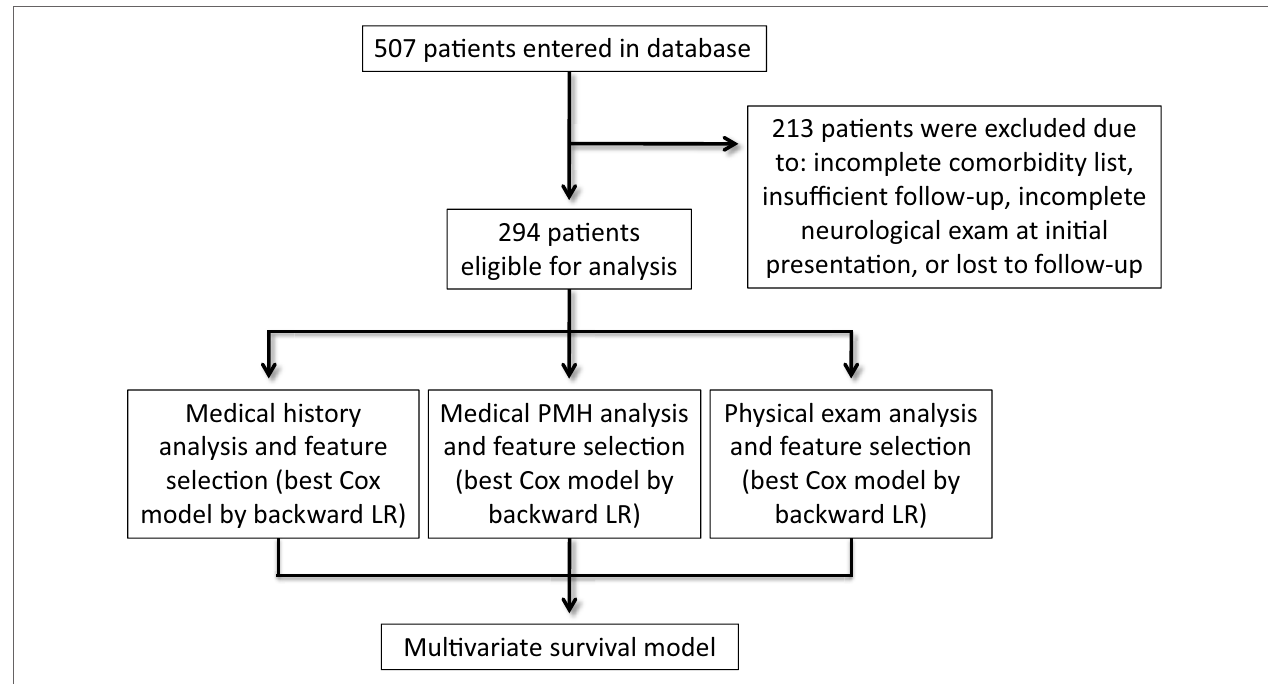
FigUre 1 | Flow chart representing the patient selection process and analytic plan